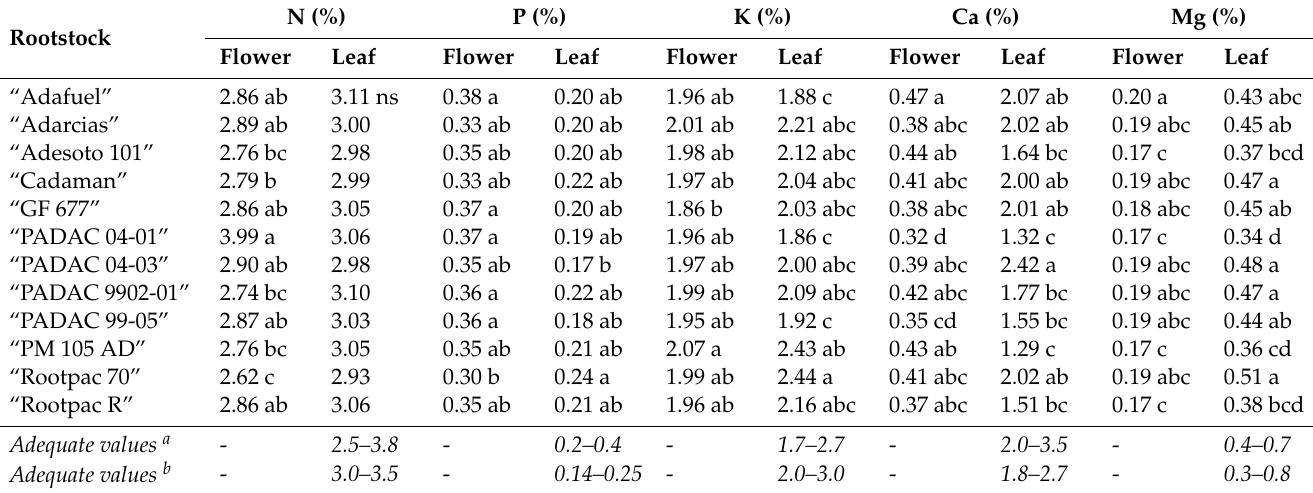
Table 9. Rootstock e ff ect on flower and leaf macro elements for “Big Top” nectarine cultivar budded on 12 Prunus rootstocks at the ninth year after planting.